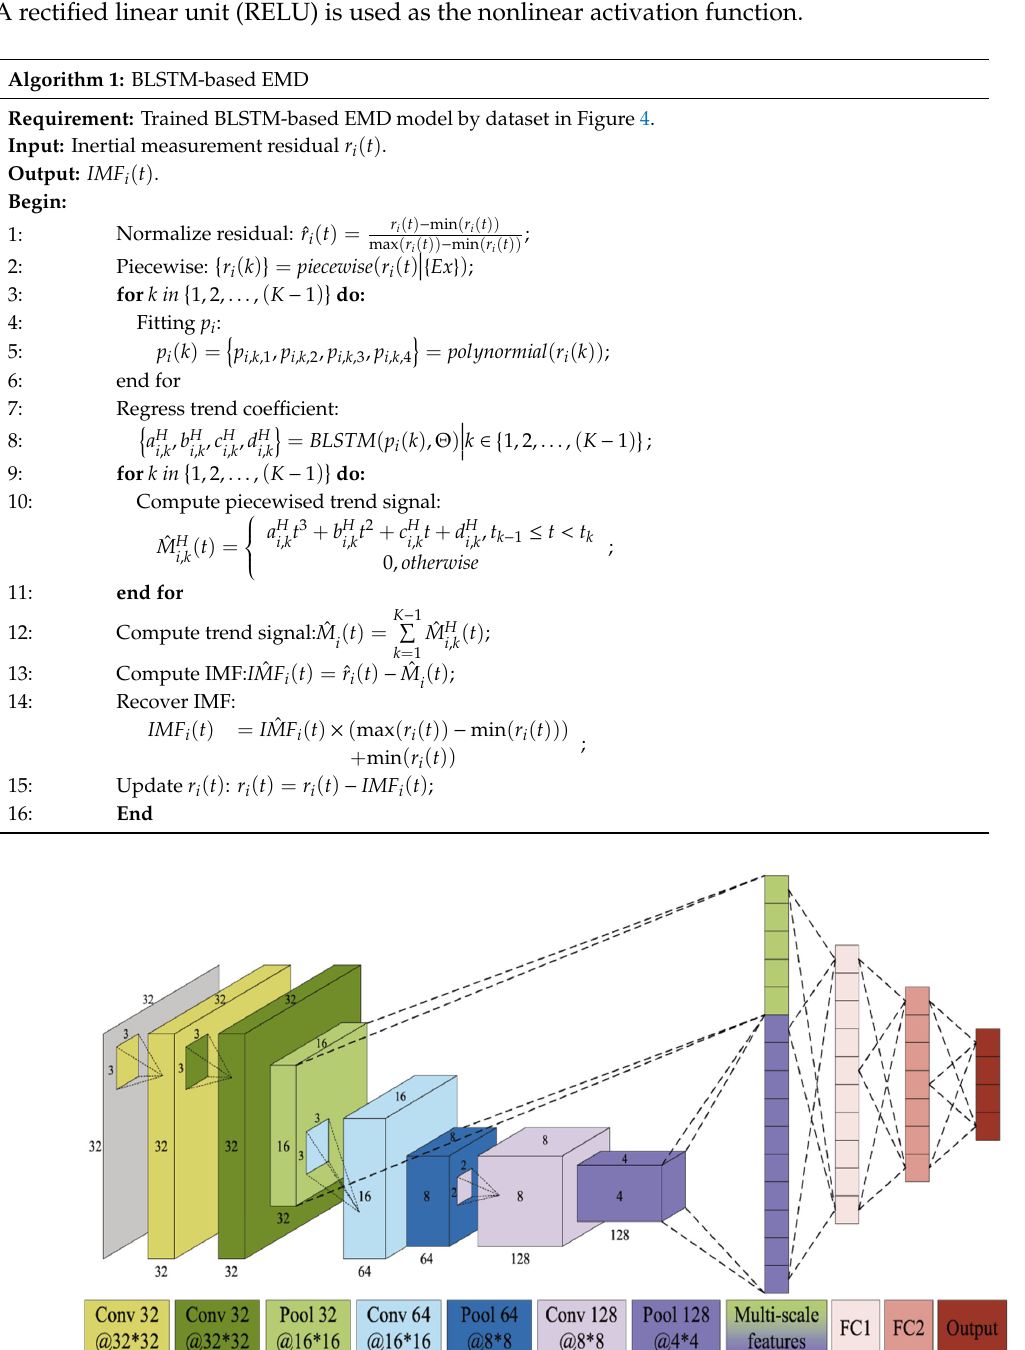
Algorithm 1: BLSTM-based EMD